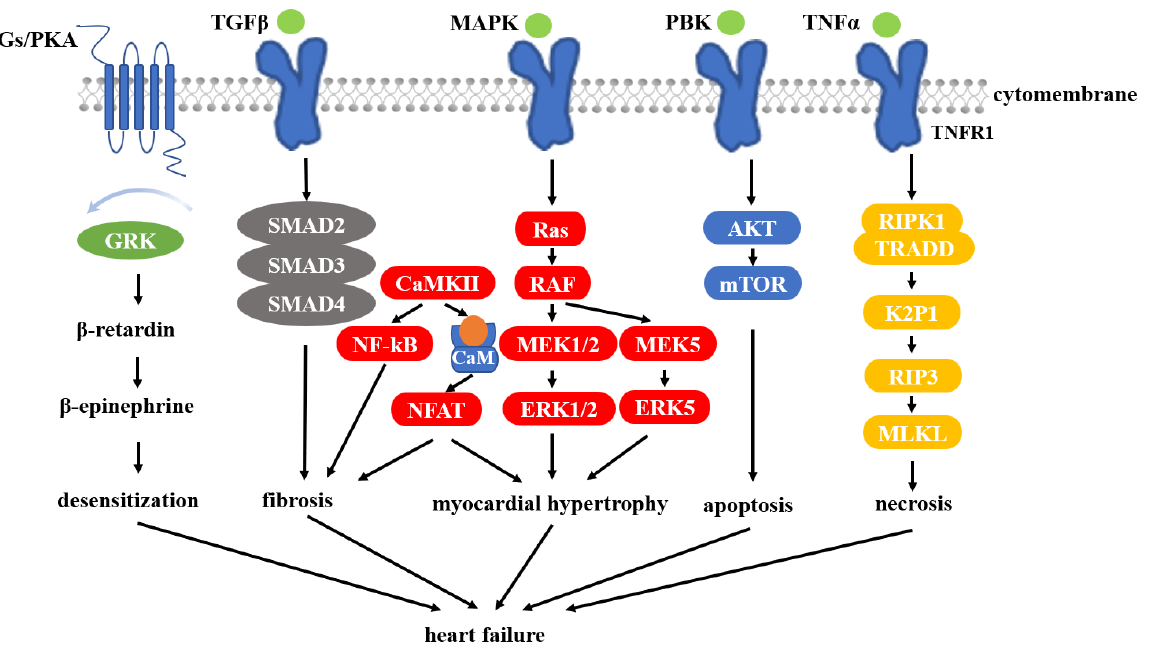
Figure 2. Pathways associated with heart failure. MAPK signaling is associated with the expression of proteins, especially those in- volved in pathways of cellular inflammation, development, differentiation, proliferation, and apoptosis [112]. MEK5 is involved in the cascade and phosphorylates ERK5, which in turn activates MEF2. Among them, MEF2 is associated with cardiomyocyte hypertrophy [113]. In addition, it was also found that HSP90 can stabilize ERK5 in the cytoplasmic matrix [114]. Major proteins in the PI3K/PKB/mTOR pathway are dependent on HSP90, so this pathway can also be used as a target for regulatory pathways. PI3K signaling is usually initiated by cytokine receptors or by the activation of RTK [115]. Among these proteins, p85, PKB, p110, eIF4E, S6K, and mTOR are all HSP90 clients [116 – 118]. A study found that inhibition of HSP90 can downregulate mTOR and PKB signaling [116,119]. There is also evidence that HSP90 is expressed at higher levels in cardiomyocytes under heat shock through PKB and PKM2 signaling and preserves mitochondrial function via phosphorylation of Bcl2 [120]. Previous studies have shown that activation of calcineu- rin/calmodulin phosphatase (CaM) dephosphorylates nuclear factor (NFAT) in T cells, which can act as a transcription factor and enter the nucleus. NFAT activation is regulated by GATA and MEF2, both genes associated with cardiac hypertrophy [121]. NFAT has been shown to be associated with cardiac hypertrophy, and, furthermore, its crosstalk with MAPK may enhance pathological results [122,123]. HSP90 stabilizes calmodulin and calcineurin, and when it is inhibited results in attenuated NFAT signaling [124,125]. The internalization of β -adrenergic is closely related to G-protein-coupled receptor kinases (GRKs), β -blockers, and various enzymes involved in endocytic proteins. Moreover, the desensitization of beta-adrenergic receptors also plays a key role in heart disease [126]. HSP90 can bind and stabilize G-protein-coupled receptor kinases GRK6, GRK3, and GRK5, which are all highly expressed in the heart tissues [127,128]. It has been found that when HSP90 is inhibited, GRK expression levels can be reduced by more than 70% [129]. It shows that targeting HSP90 can inhibit the desensitization of β -adrenergic receptors and prevent the development of cardiomyopathy and HF. Tumor necrosis factor alpha (TNFα) signaling activates apoptosis, proliferation, necrosis, and inflammatory responses in cells.